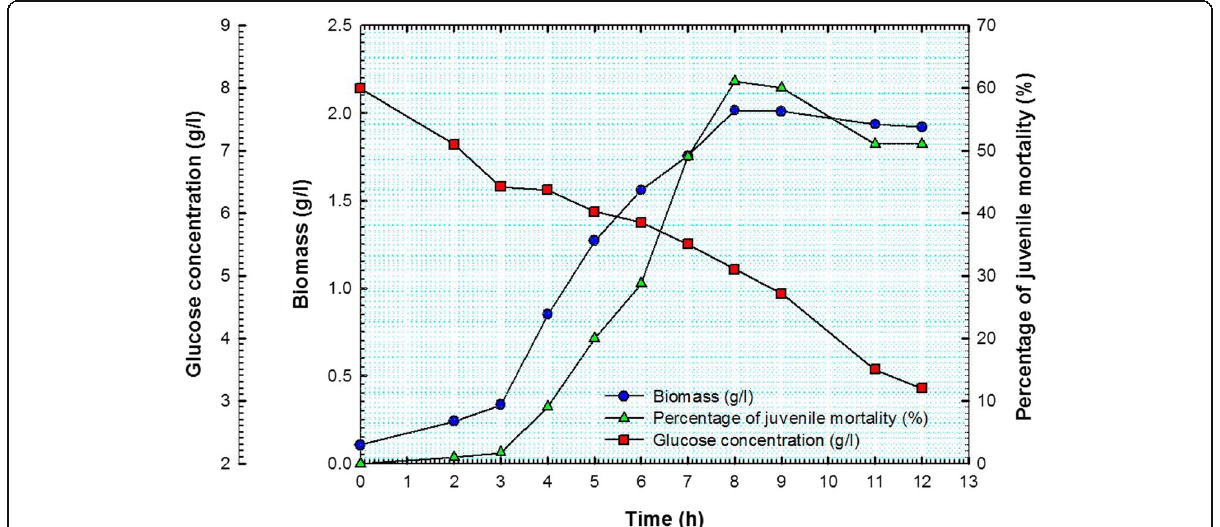
Fig. 5 Biomass, percentage of juvenile mortality at a concentration of 5% and glucose concentration as a function of time for batch fermentation no. 1 of Bacillus subtilis isolate B10